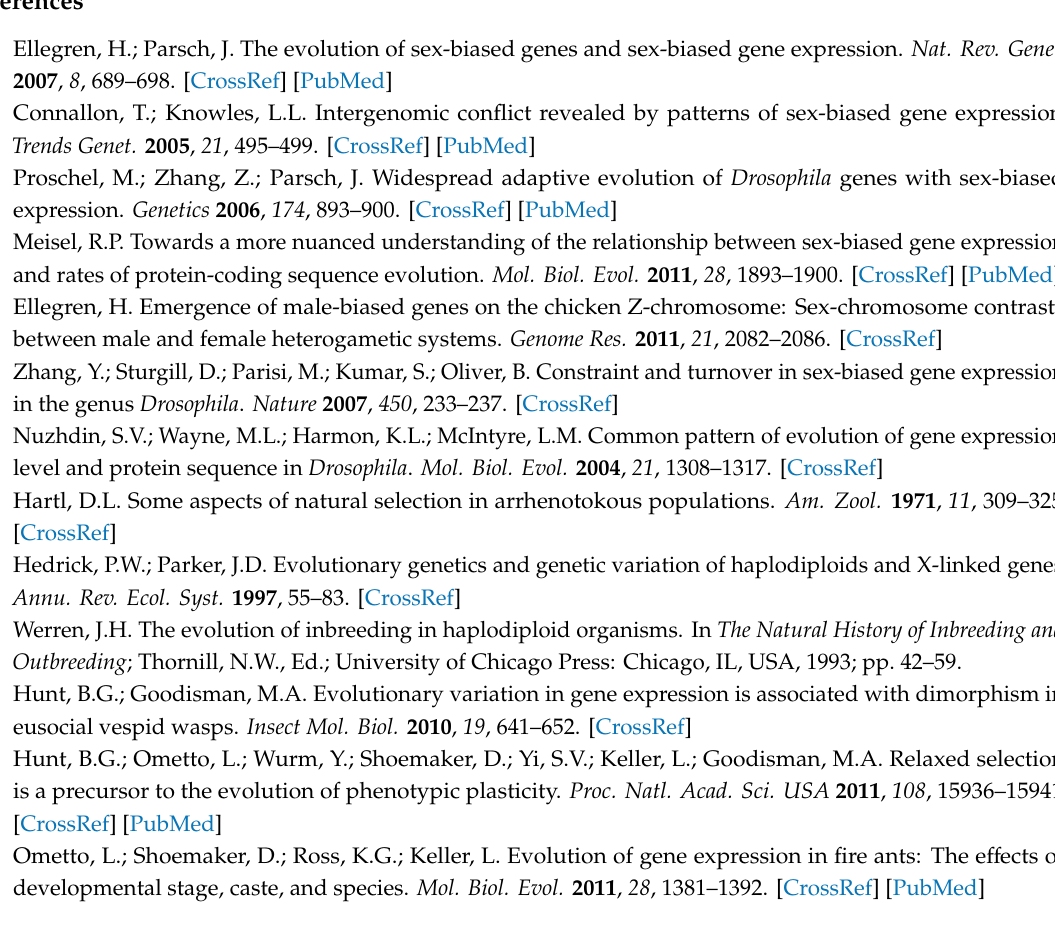
Figure S1: Phylogeny trees of gene expression based on pairwise distance matrices, Figure S2: Distributions of the gene number and the Ka / Ks ratio in gene expression variation of sexes for common orthologous genes, Figure S3: Distributions of Dx, Vx, and Rx in gene expression variation in sexes, Figure S4: The evolution of protein coding sequences and gene expressions in each of the detailed categories, Table S1: Summary for transcriptome assembly of MEAM1, MED, and Asia II 3 whiteflies, Table S2: Statistics of gene expression data through mapping to the transcriptome of each species, Table S3: Correlations of biological replication of each sample (R 2 ), Table S4: The number of sex-biased expression genes in the three Bemisia species, Table S5: Statistics of the Ka / Ks ratio between each pair of two species among